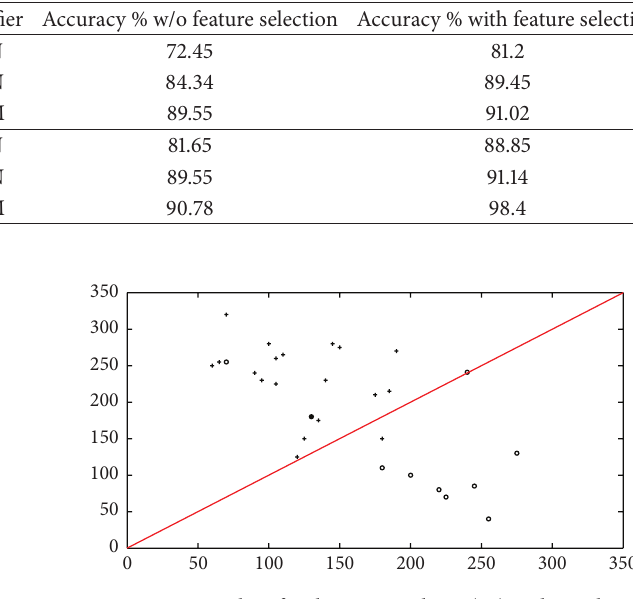
Figure 11: Scatter plot of real-time sample set (30) on SVM classifier for benign and malignant tumor in real-time image dataset. Here “ ∘ ” denotes tumor malignant prognosis and “+” denotes patients with benign tumor prognosis.